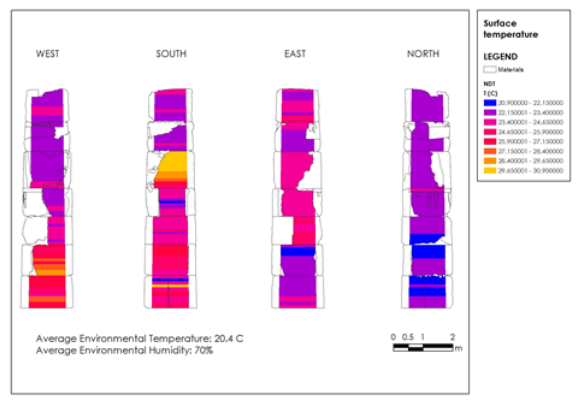
Figure 13: Thematic mapping of surface temperature